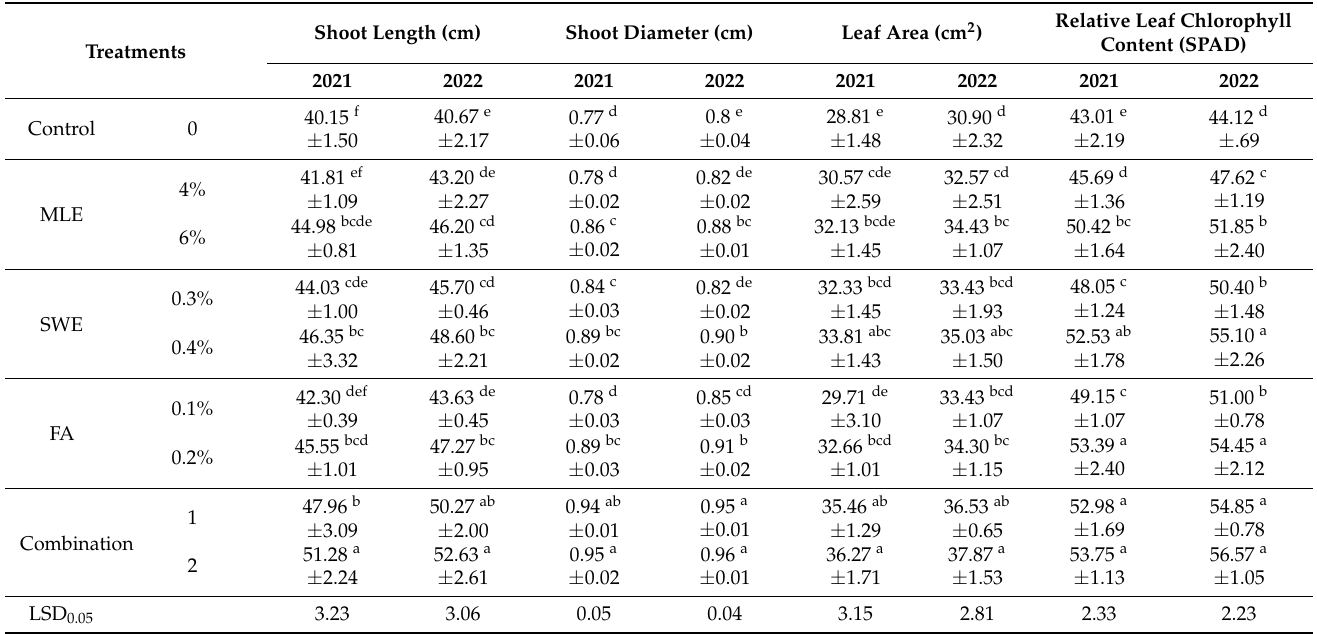
Table 2. The influence of the spraying of MLE, SWE and FA and their combinations on some vegetative growth parameters of apple cv. Anna during 2021 and 2022.